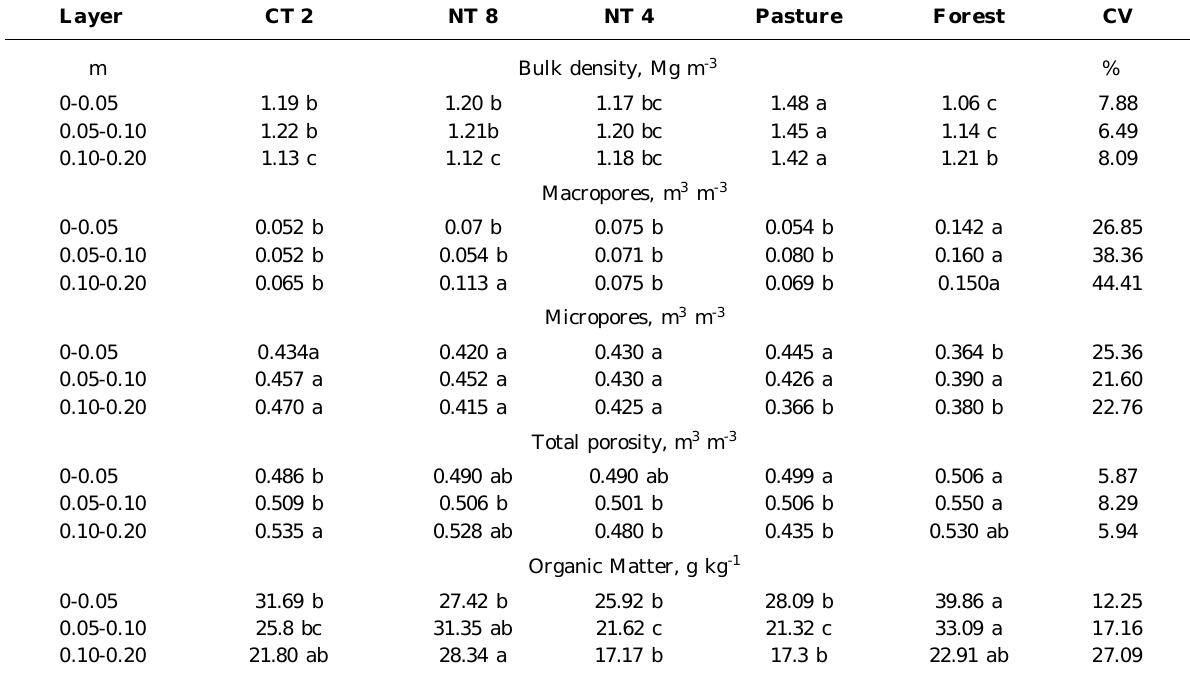
Means of the areas followed by the same letter did not differ from each other by the Tukey test at 5 %